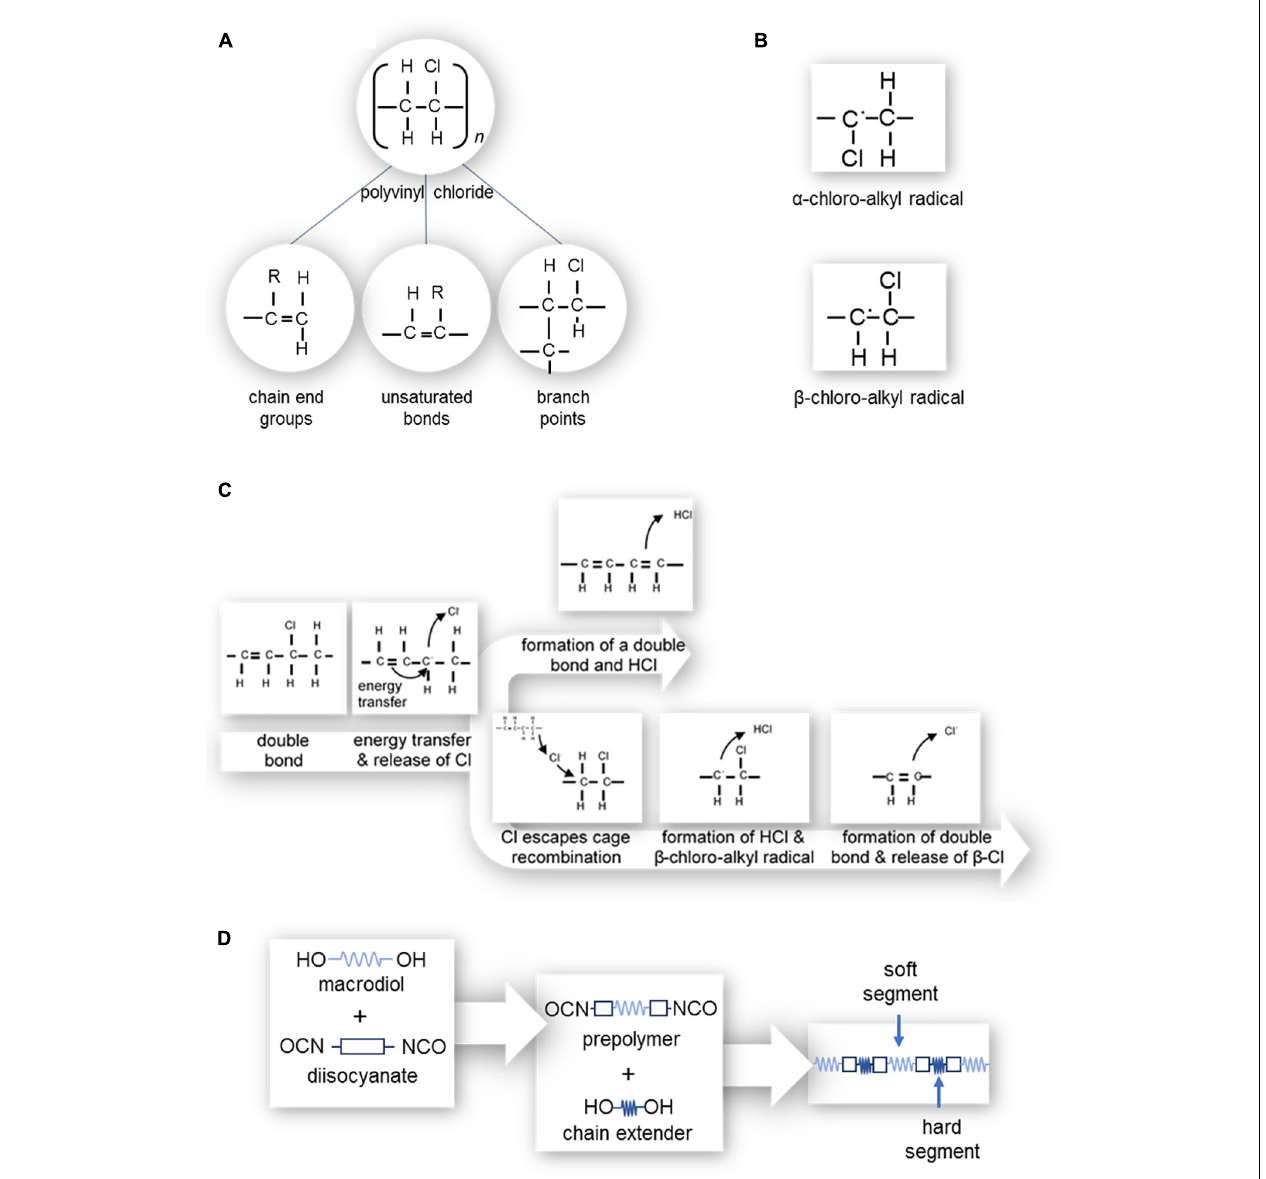
FIGURE 5 | (A) Polyvinyl chloride structure and possible defects, where the R can be either a hydrogen or chlorine atom; (left) chain end groups with an unsaturated bond, (center) branch points, and (right) unsaturated bonds along the length of the polymer chain. (B) α -chloro-alkyl and β -chloro-alkyl free radicals. (C) Zip dehydrochlorination of PVC. (D) Polymerization of